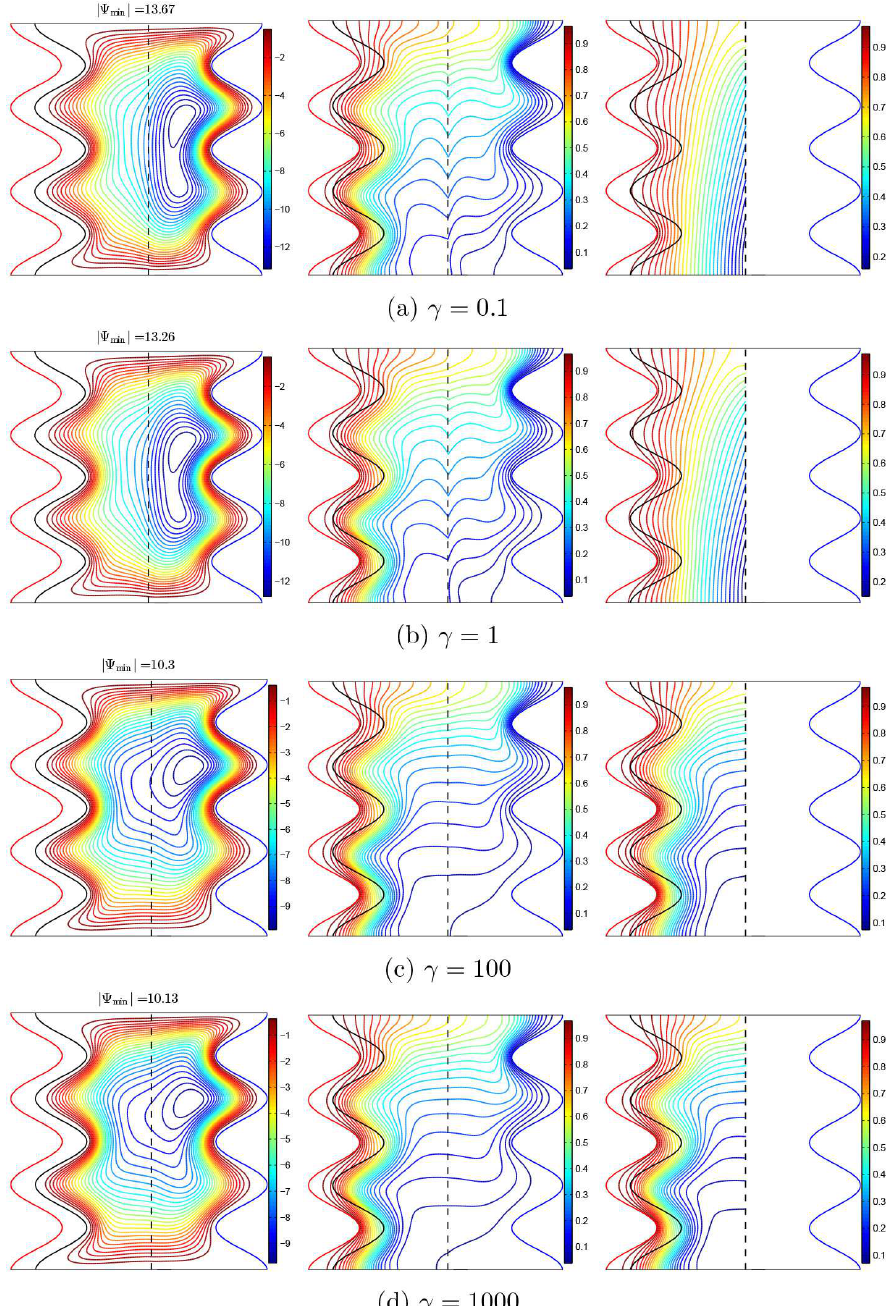
Figure 7. Streamlines ( left ), the isotherms of the nanofluid phase ( middle ), and the isotherms of the solid phase ( right ) with various modified conductivity ratios ( γ ); Da = 10 − 3 , φ = 0.02, A = 0.1, and ε =